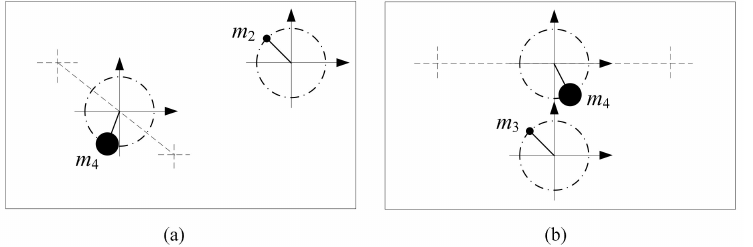
Figure 9. Motion state of two-thirds of ERs using control synchronization: ( a ) controlling motor 1 and 3; ( b ) controlling motor 1 and